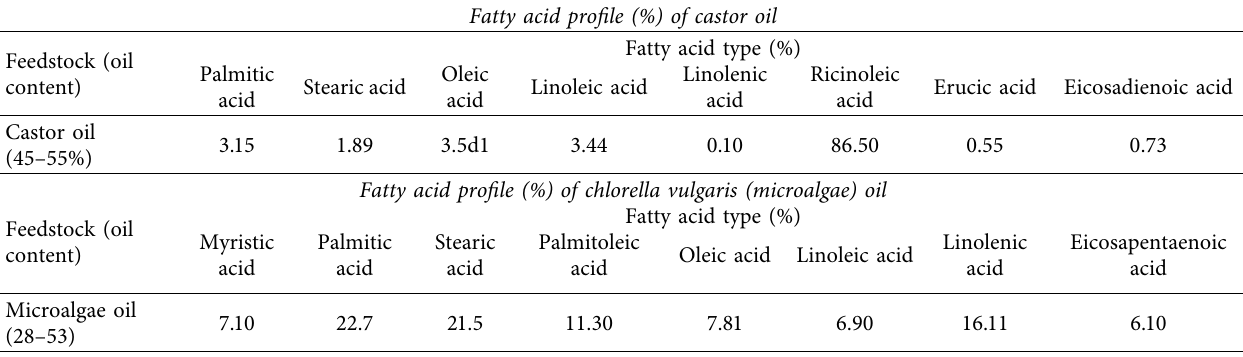
Table 3: Fatty acid profiles of castor seed oil and microalgal oil. Fatty acid profile (%) of castor